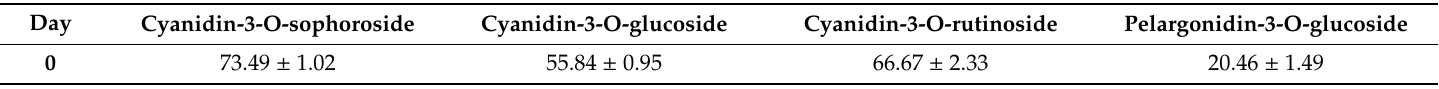
Table 11. E ff ect of storage period, from the fruits at harvest on the di ff erent anthocyanidin compounds content in red raspberries (cv. Erika). Results are expressed in µ g / g of fresh weight. The results are the mean of three replicates ± Standard Deviation.